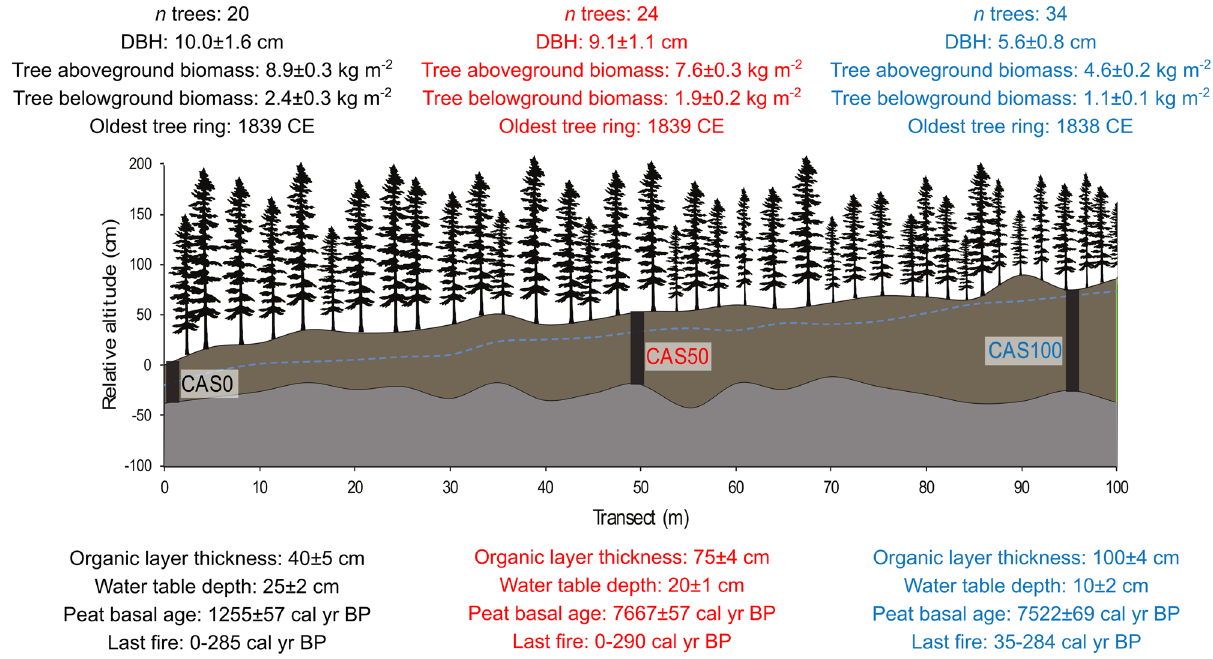
Figure 2. Schematic representation of the transect and characteristics of the three study sites. The relative altitude of the organic layer and the mineral surfaces are shown in brown and grey, respectively. Black rectangles correspond to the peat cores sampled and the dotted blue line illustrates the water table level measured on the field. Trees are not to scale but are representative of the variation in canopy openness with peat thickening. Tree counting was performed within a 10 × 10 m plot at each site. Standard errors are shown by ± values. Drawing was generated using Inkscape